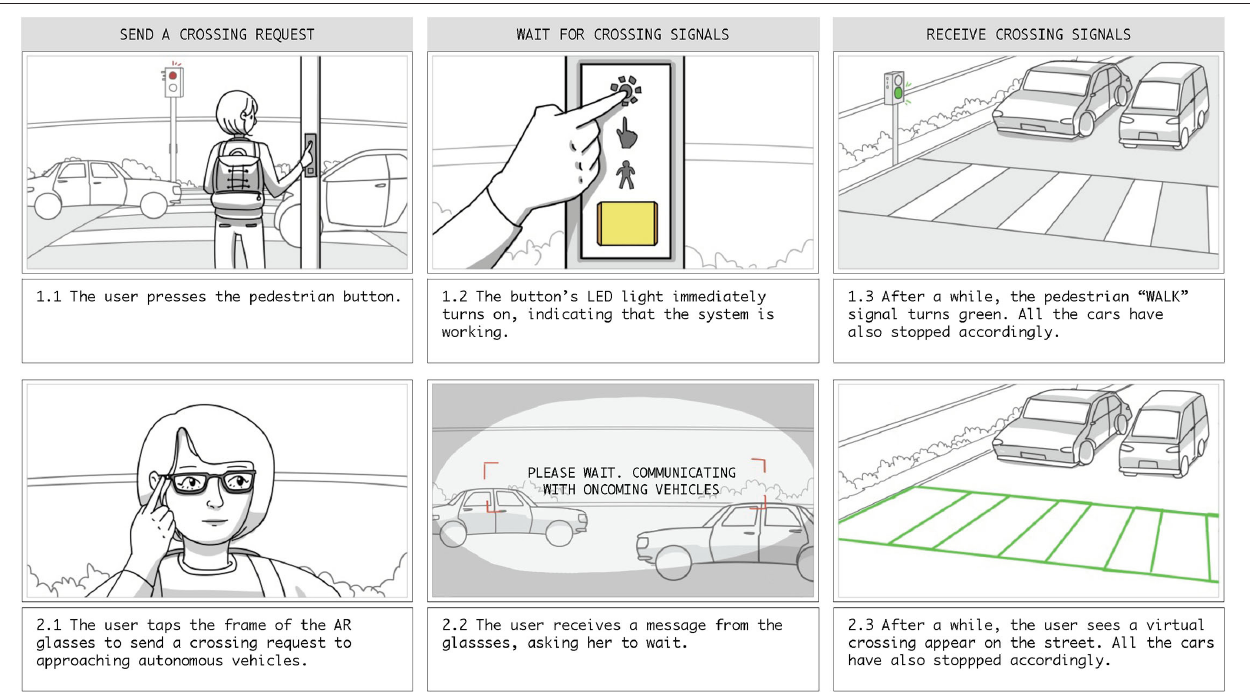
FIGURE 1 | Storyboard illustrating three-stage user interactions of the pedestrian button (top) and AR glasses (bottom). Only visual signals were depicted to keep the storyboard simple.